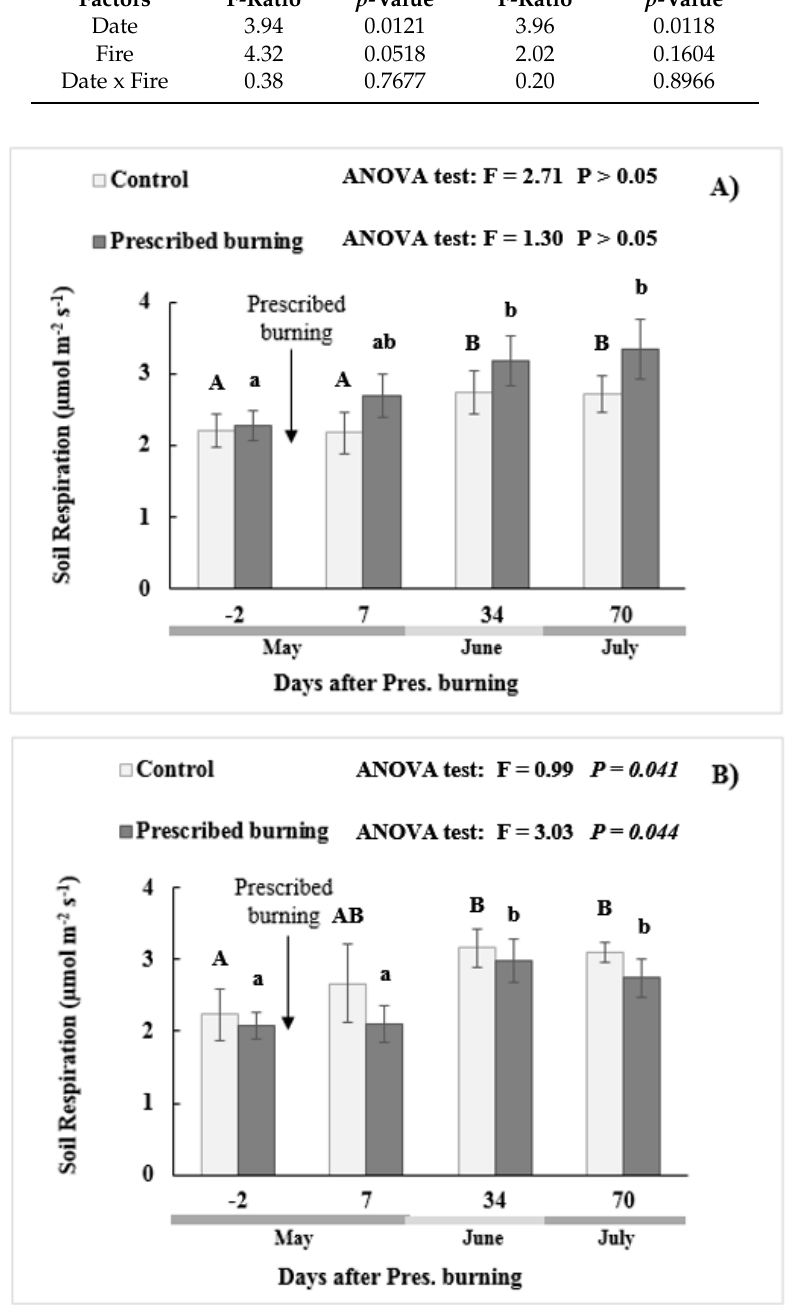
Figure 2. Temporal evolution of the soil respiration rates (mean ± SE) in the control and burned zones (µmol m − 2 s − 1 ). ( A ) corresponds to the pure stand and ( B) to the mixed stand. Bars with different capital letters represent the significant differences between the temporal times of the control treatment, while different lower-case letters show the differences between the temporal times in the burned plots. No differences were found between the burn treatment and the control within each time as there were no significant differences.